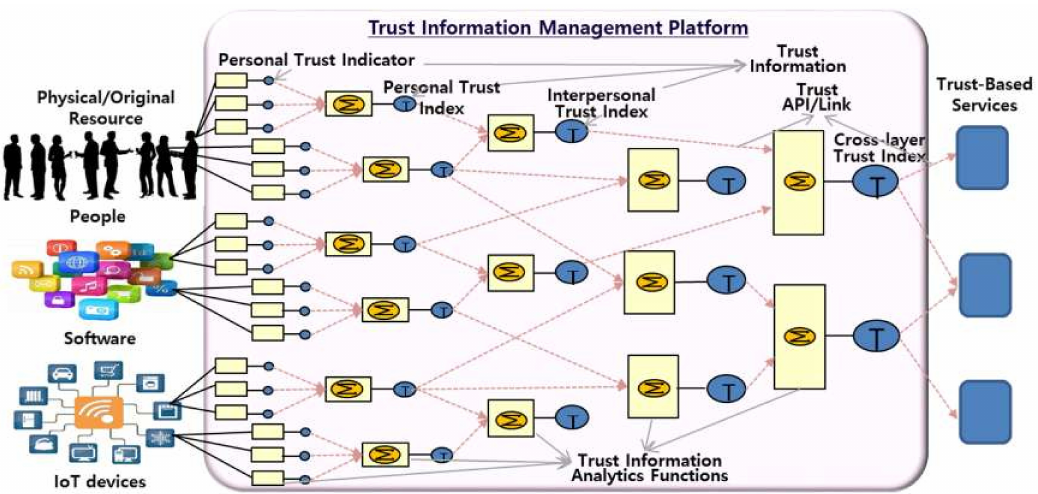
Figure 5. The procedure of trust data analytics.